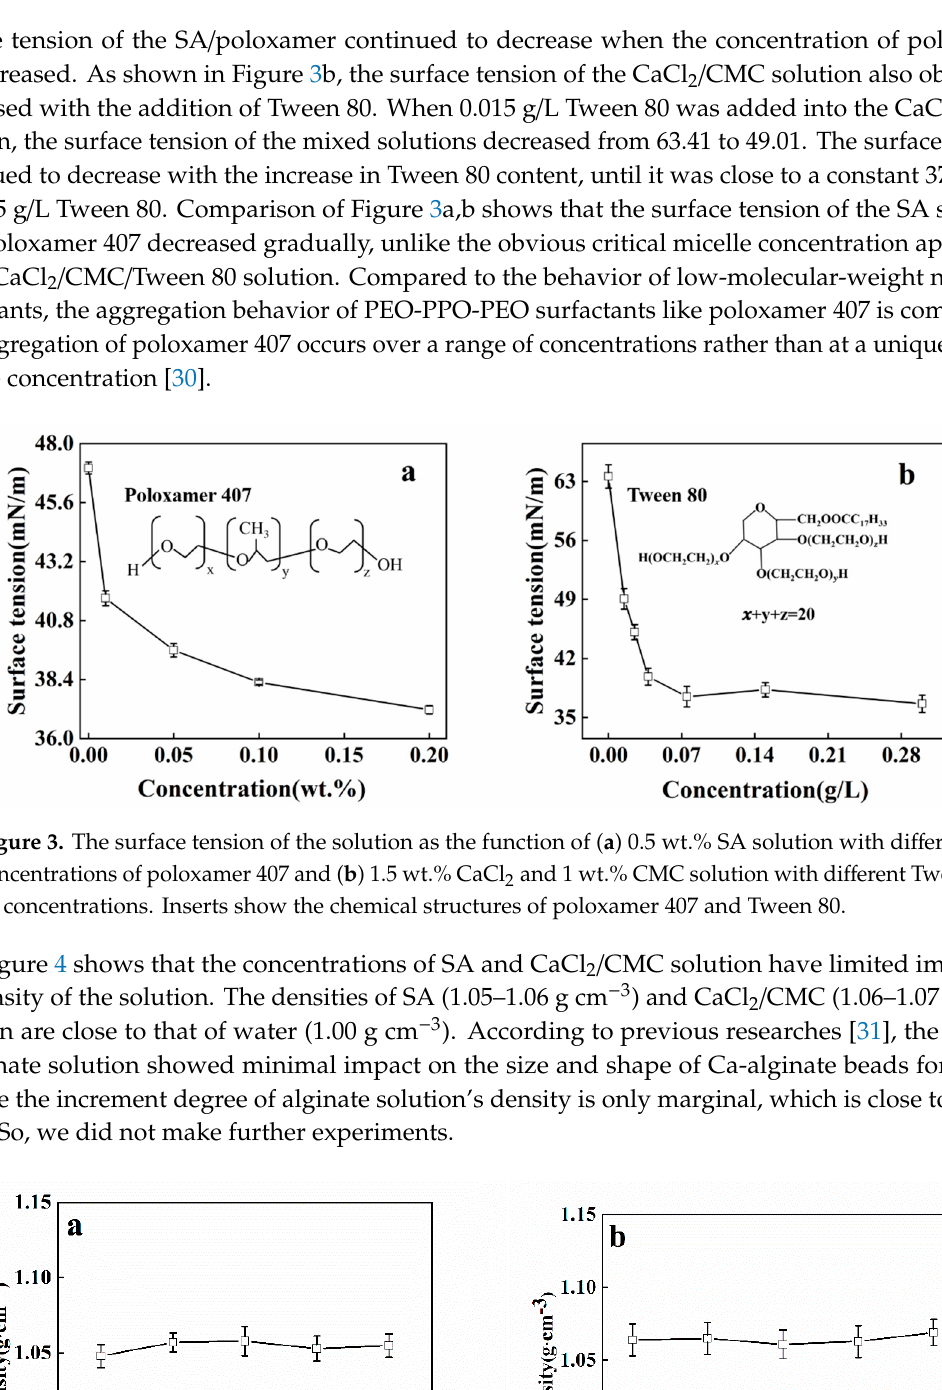
Table 1. Effects of viscosity of SA and CaCl 2 /CMC solutions on the sphericity factor ( SF ) of mm-CaSA- Caps.